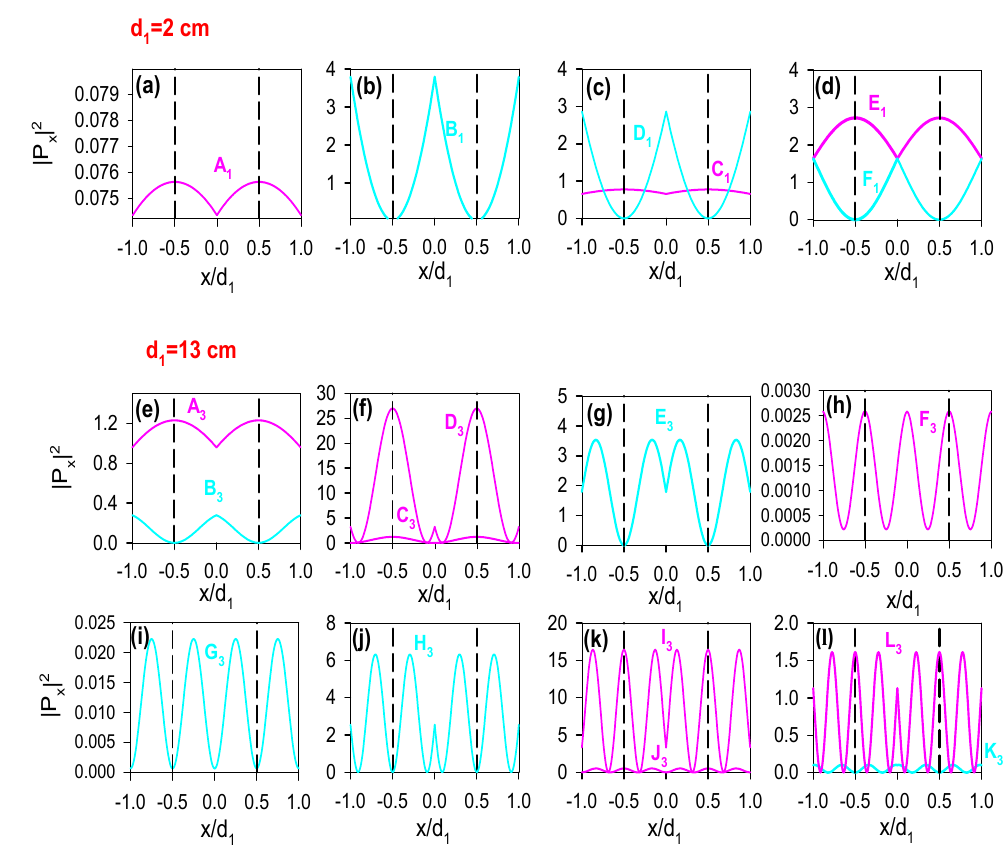
Figure 4. ( a – l ) Square modulus of the pressure field of different band edge states labeled A 1 – L 3 , respectively, for d 1 = 2 cm and d 1 = 13 cm. Pink and cyan colors indicate the symmetric and antisymmetric edge modes,